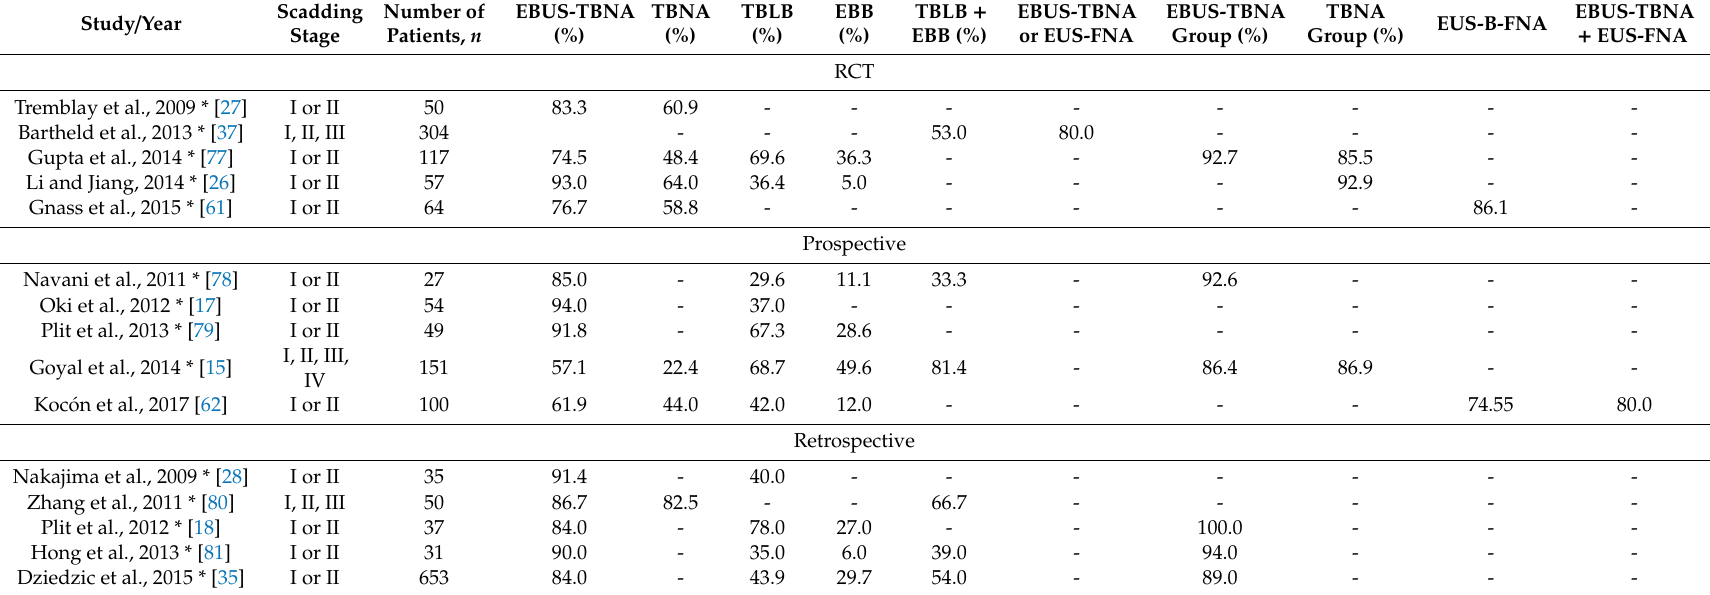
Table 2. Diagnostic yield for sarcoidosis of the di ff erent bronchoscopic modalities among the distinct studies (adapted from Hu et al.